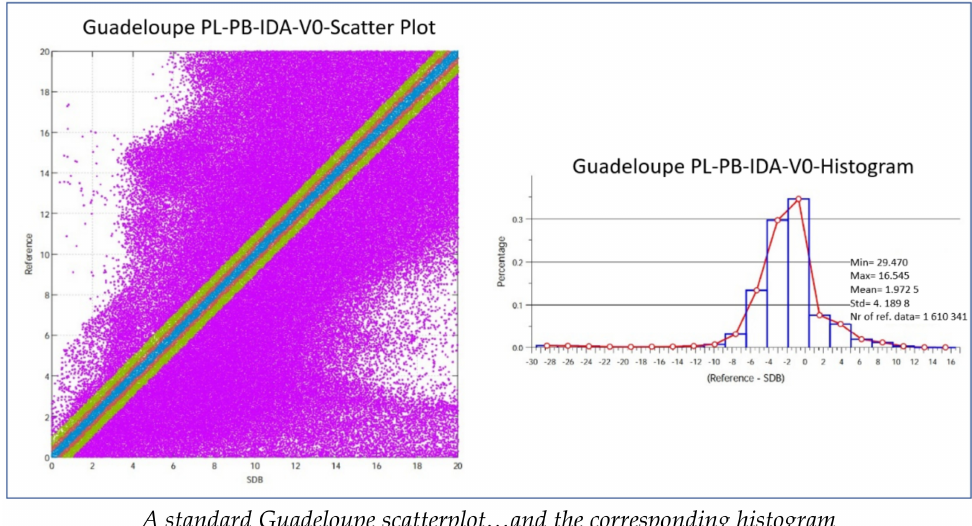
Figure 5. Comparison of Guadeloupe scatterplot and histogram against S-44 orders of precision. IHO S-44 Compliancy cannot be met in large zones.